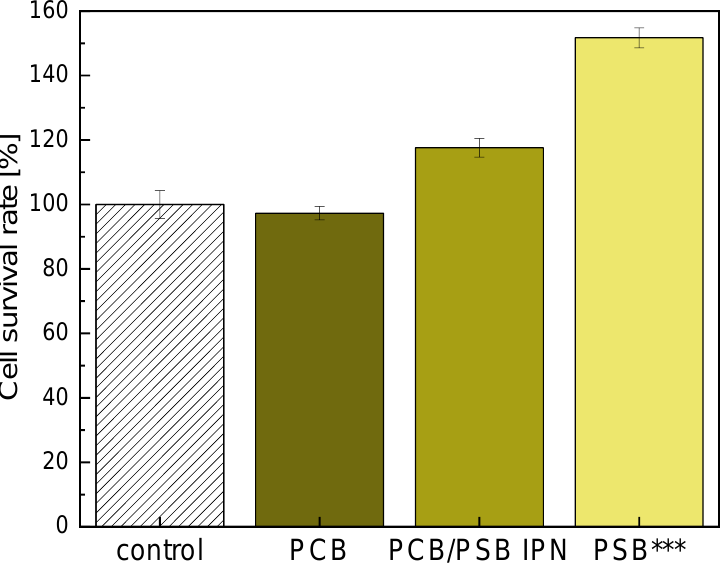
Figure 7. Viability of human embryonic Lep-3 cells seeded on the PCB/PSB hydrogel, assessed with cell proliferation colorimetric assay test (MTS) after 24 h incubation (*** p < 0.001 as compared to the control).